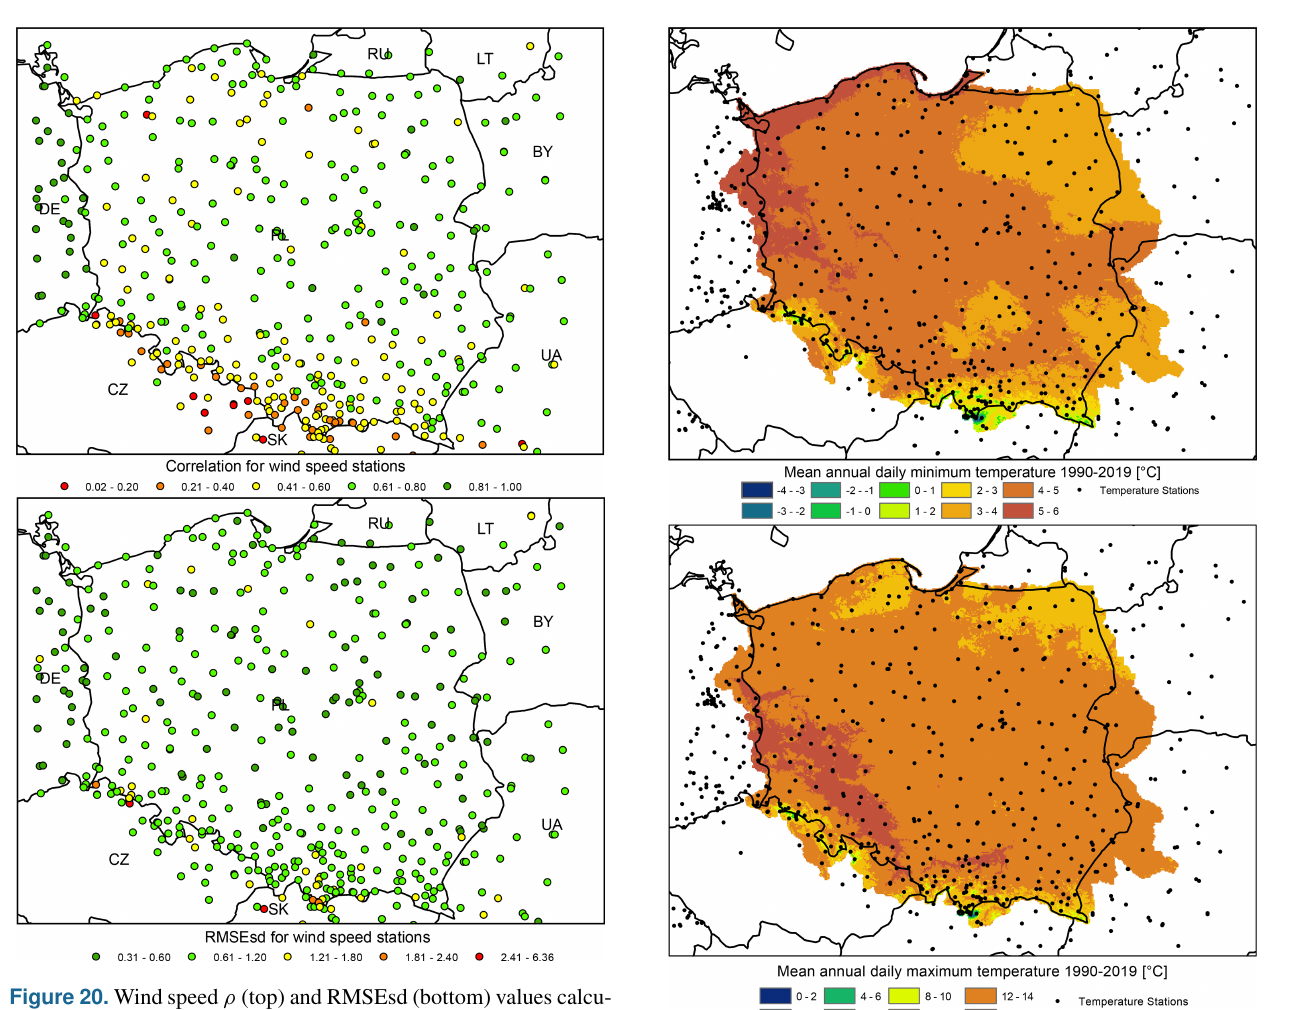
Figure 20. Wind speed ρ (top) and RMSEsd (bottom) values calcu- lated for stations in the period 1951–2019. National borders (black lines) are labelled with country codes.